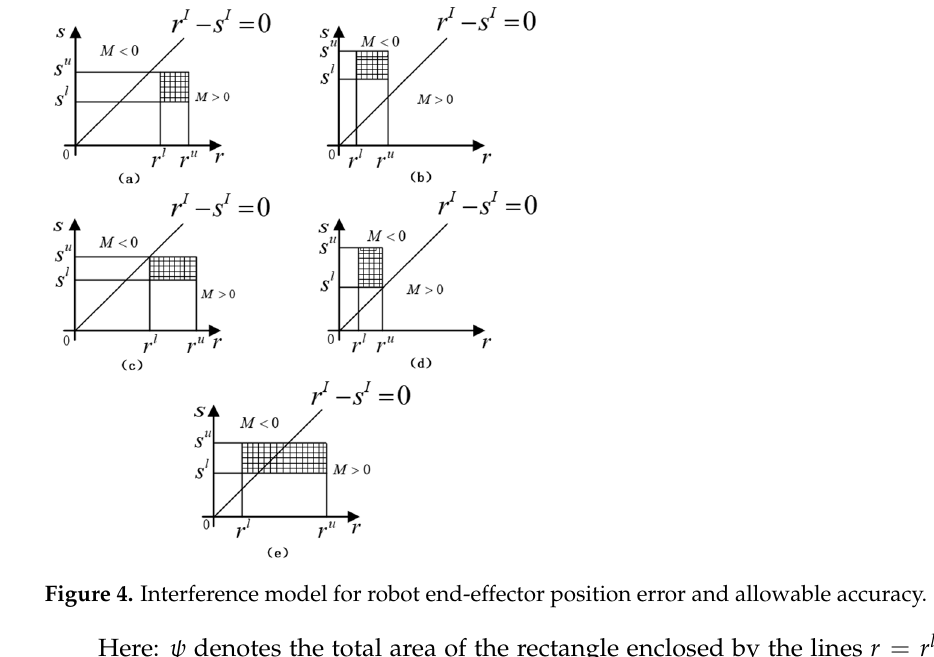
8 of 23 Figure 3. Interval function. According to the above analysis, the robot end position reliability can be measured by comparing the value of the function M of the robot end position error expressed by the interval number with the number 0. In addition, using non ‐ probability reliability [25] (the ratio of the area of the reliability domain to the total area of the domain of the basic interval variables) can be a more convenient measure of the reliability of the robot end position. Figure 4 shows the relationship between the position error interval and the allowable error interval on the coordinate system. Let